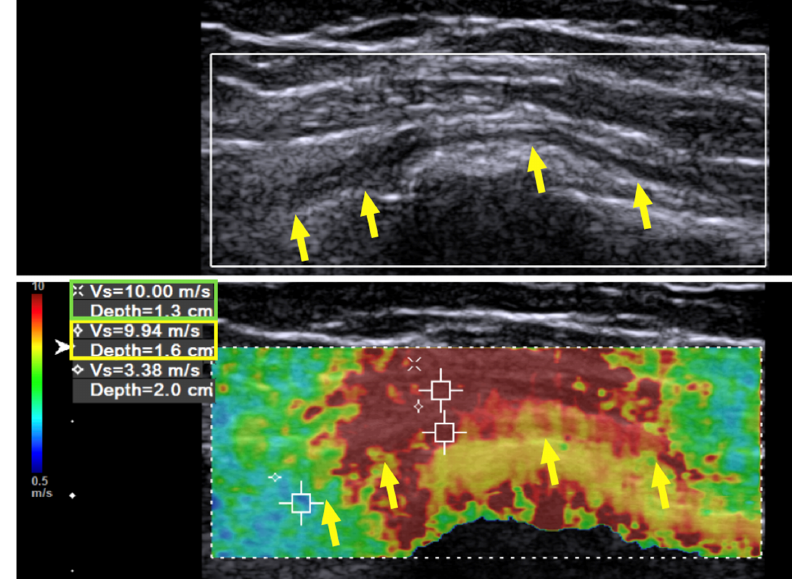
1 Figure 1. Case 1: Shear wave velocity before hydrodissection. Shear wave velocity (SWV) investigation of the radial nerve over the spiral groove before hydrodissection in a 31-year-old man with wrist drop following plate removal after humerus fracture osteosynthesis. Multiple regions of interest are selected, including the radial nerve and the surrounding tissues. The SWV of the radial nerve is 9.94 m / s and that of the surrounding soft tissue is 10 m / s. Yellow arrow and box: radial nerve in longitudinal view. Green box: scar